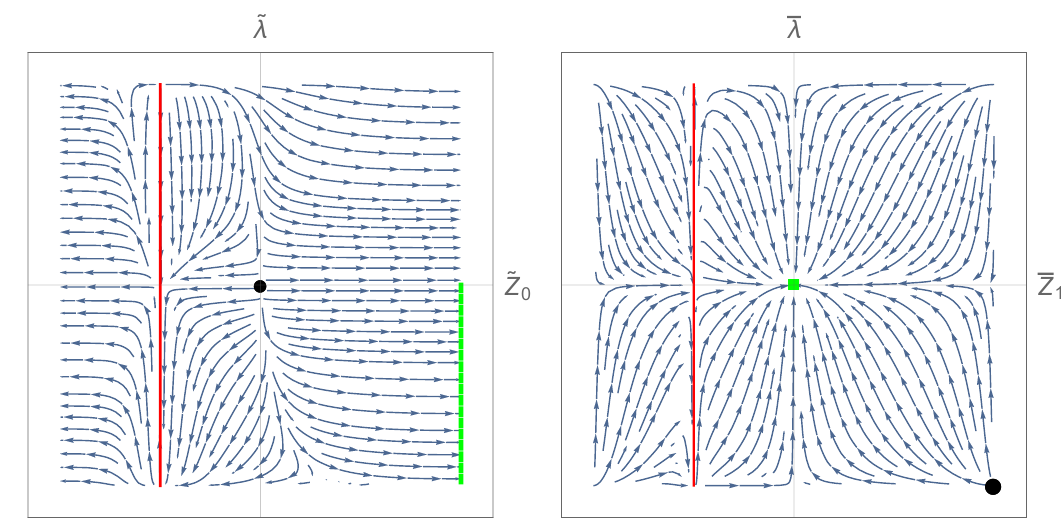
Figure 2 . The flow in the chart U 1 (left) and in the chart U 0 (right). Flow lines in the lower right quadrant go from GFP 1 (black) to GFP 0 (green). The vertical red lines are singularities of the flow. The beta function of Z is zero, and so is the anomalous dimension η = − ∂ log Z . There 1 1 t 1 are no FPs in this chart except for GFP . Using the rescaling u = tan( ˜ Z ) and v = tan(˜ λ ) , 1 0 the flow lines have the form shown in figure 2. We recognize that λ is asymptotically free for λ < 0 , as was noticed by Symanzik [17]. The fact that the flow lines asymptote horizontally is due to the decoupling effect of the denominators: for sufficiently small k , the running of λ stops whereas ˜ Z continues to run due to the classical 0